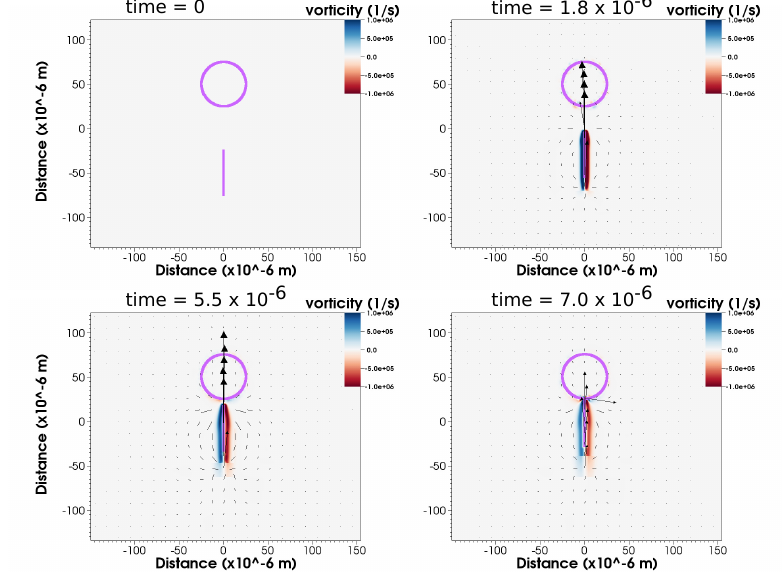
Figure 4. Time series for Re = 900 at the base length and radius. The prey and barb are denoted by magenta. The color map shows the vorticity, and the arrows show the magnitude and direction of fluid velocity. Note that the prey is untethered and moves with the fluid so that the internal velocity is not indicative of flow through the